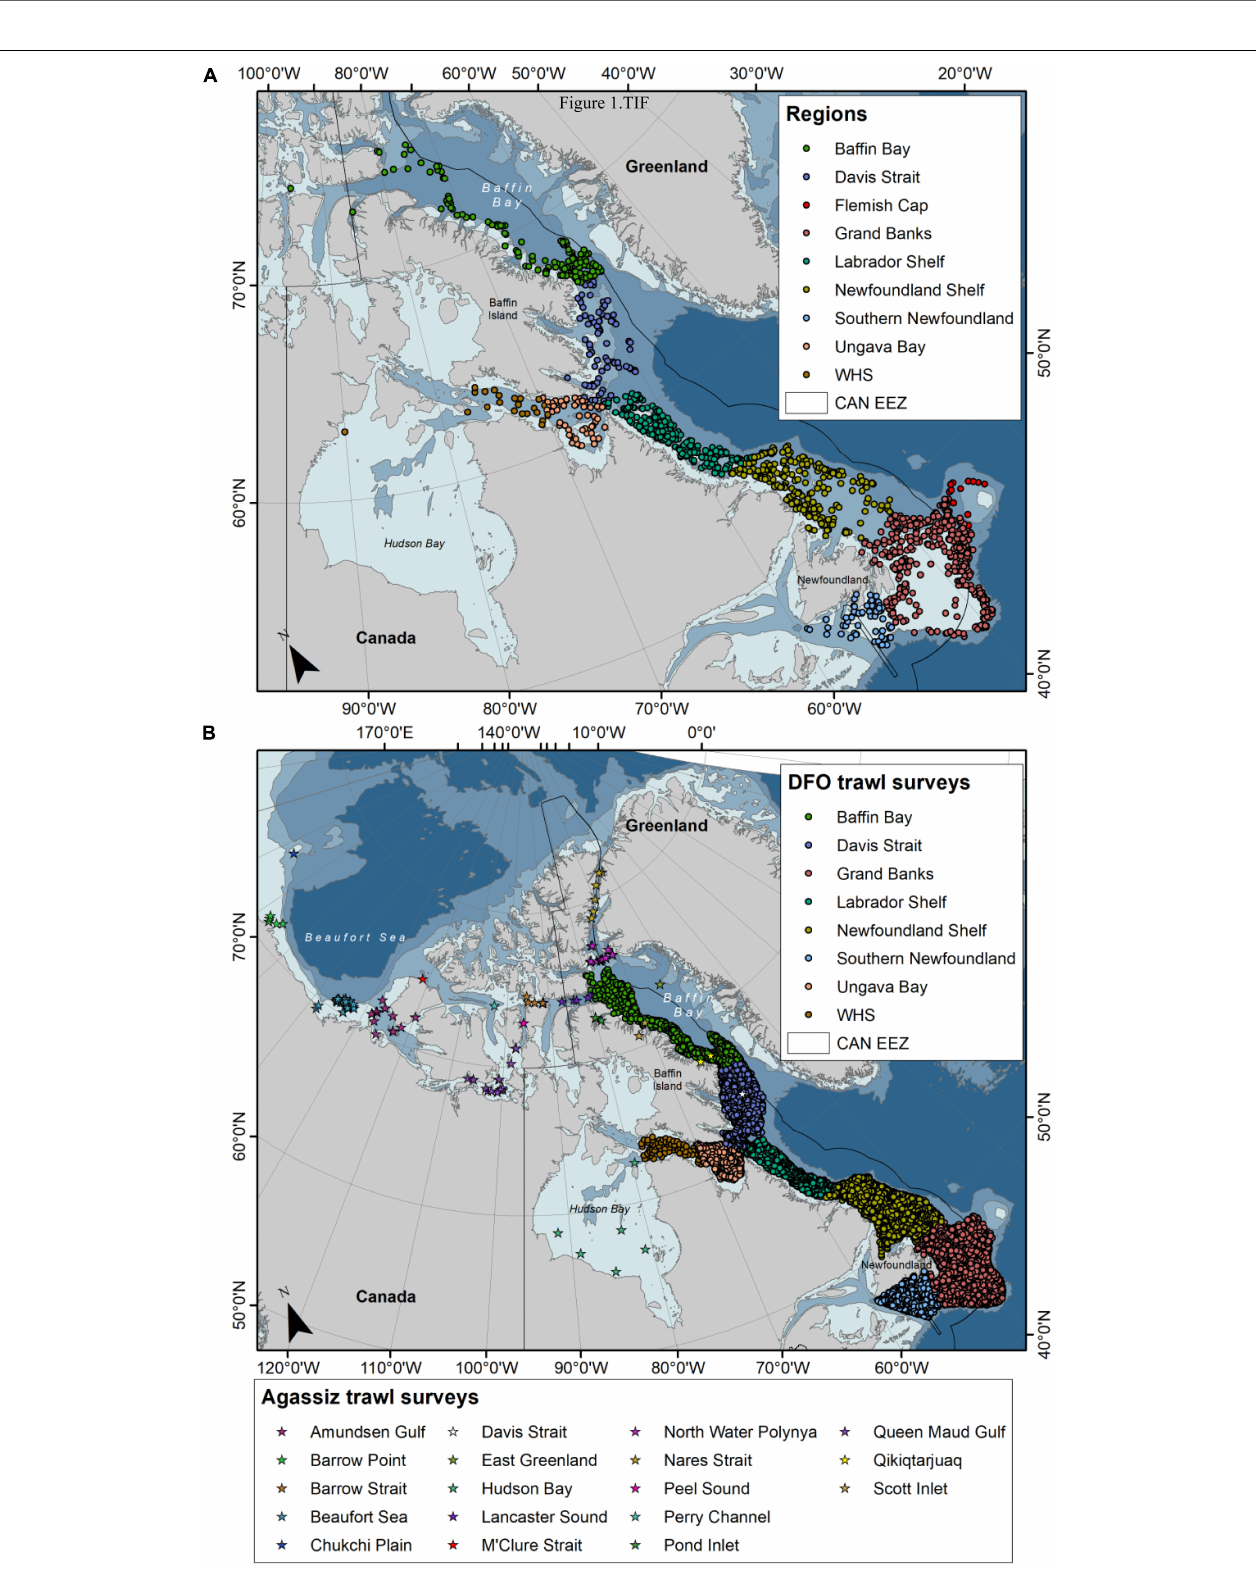
FIGURE 1 | Distribution of (A) Nephtheidae soft coral colonies inspected for the presence of clinging basket stars (2003–2015), and (B) trawl databases examined for the presence of basket stars and Nephtheidae soft corals, where dots represent DFO trawl surveys (2011–2017) and stars represent Agassiz trawl surveys